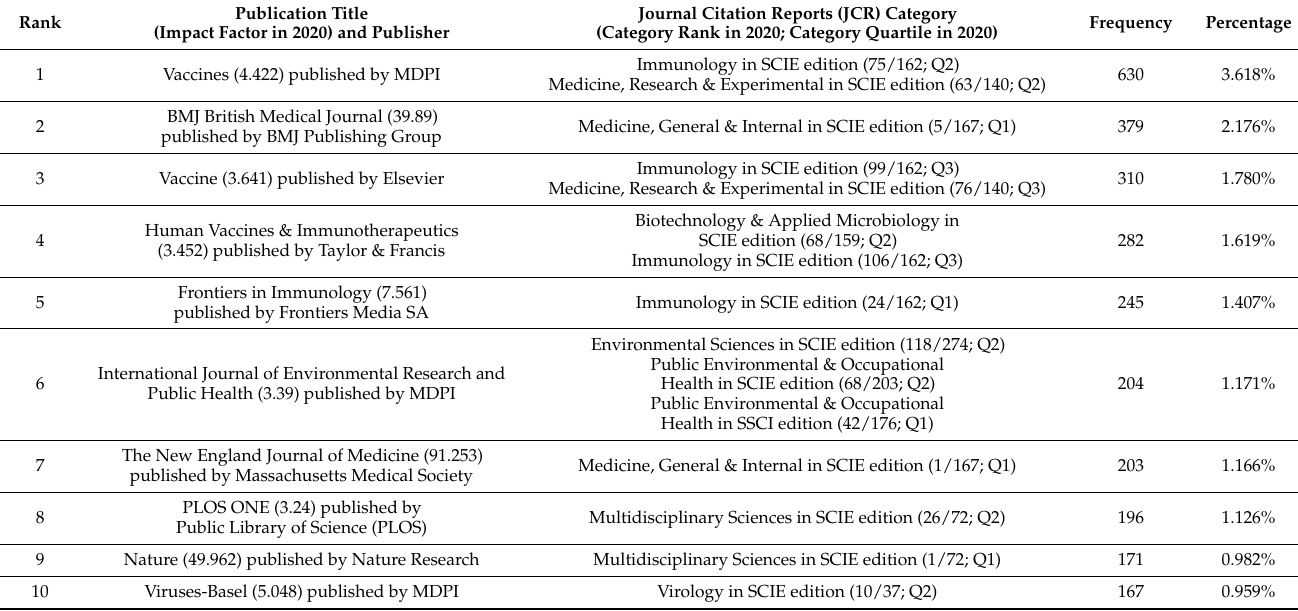
Table 4. The top 10 journal titles for publications on COVID-19 vaccines.